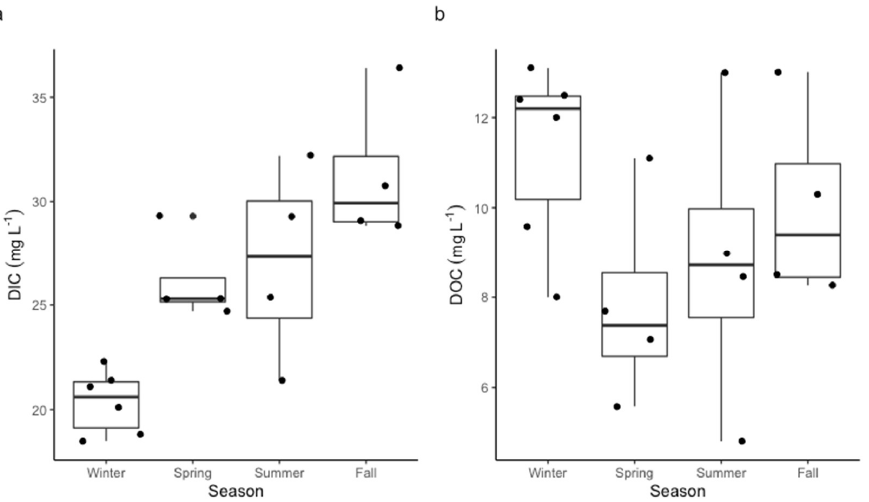
Figure 2. Boxplot of seasonal variability of ( a ) DIC; ( b )DOC. Dots are sample points from each field trip. The DIC: DOC ratio within the Mississippi River increased steadily throughout the year from a low in March (1.4) directly following the cold winter event to a high (6.1) in late August following a month-long heatwave with temperatures averaging >29 °C. The ratio of DIC: DOC remained below 2.0 for one of the winter samplings dates (19 March), which was on the latter end of the season when temperatures and discharge of the river had begun to rise. The ratio remained above 2.0 for the remainder of the year aside from one sample point in July following a two-week period where river discharge rose 30%. Table 2. DIC, DOC, NO 3 and NO 2 and river discharge across all sample dates . Sample Date DIC mg L −1